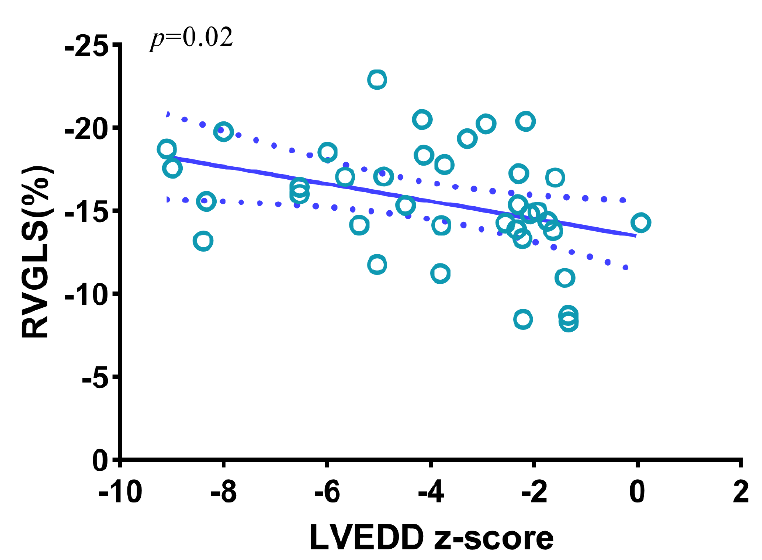
Figure 1. Correlation between RVGLS and LVEDD z-score. RVGLS, right ventricle global longitudinal strain; LVEDD z-score, left ventricular end diastolic dimension z-score. Diffusion tensor imaging showed that FA values increased (0.18 ± 0.01 vs. 0.21 ± 0.02;